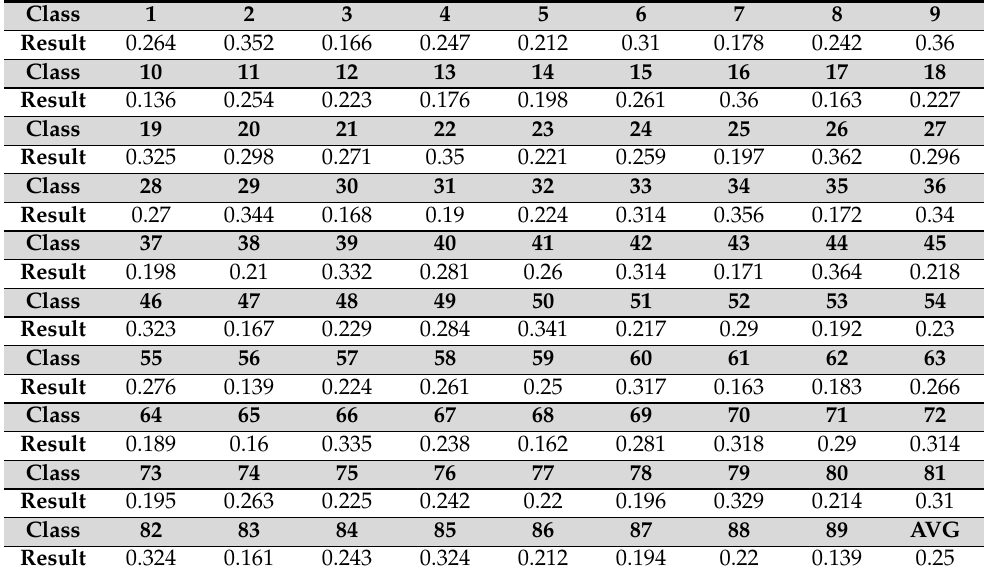
Table 3 is the similarity measurement results using Euclidean distance based on the cross correlation by experimentee, and it shows the similarities from 0.136 minimum to 0.364 maximum, with the mean Euclidean distance showing a similarity result of 0.25. In the results of using the network proposed, the directivity features are very similar to the real ECG signals, and the synthetic ECG signal generation results have different correlation waveforms between the experimentees. This means that the generated synthetic ECG signals were similar to the real ECG signals, and even if the registration and comparison data do not have the same size, the data size inconsistency problem was solved through synthetic data generation. Table 3. Similarity measurement results using euclidean distance on the basis of cross correlation.